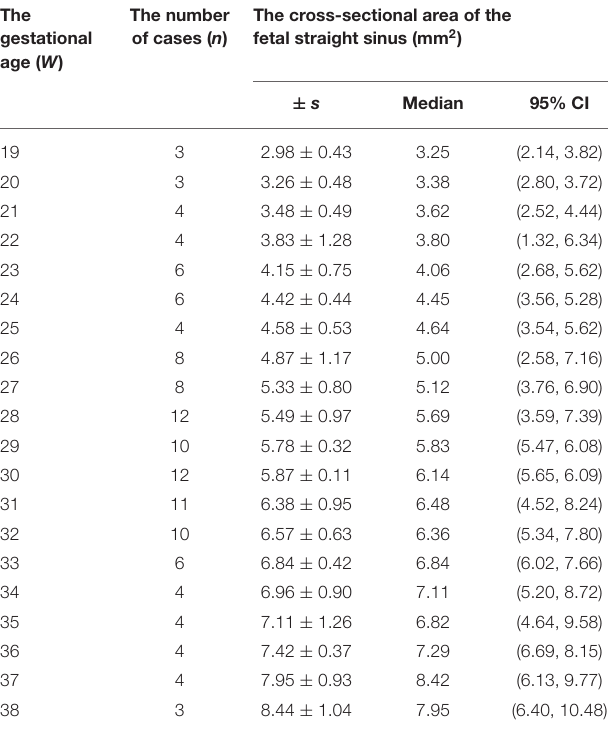
TABLE 1 | The measurement of the cross-sectional area of the fetal straight sinus. The gestational